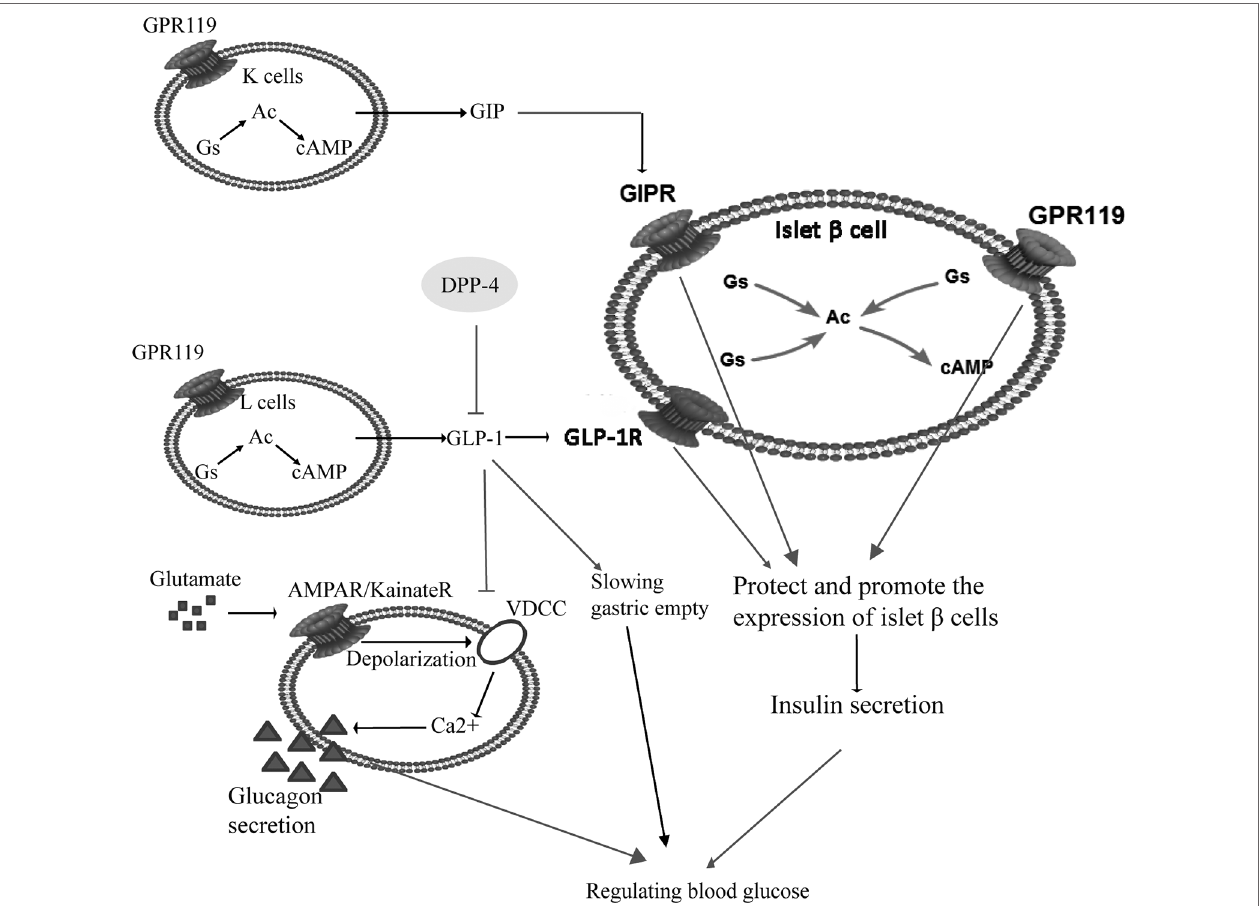
FIGURE 1 | The pathogenesis of type 2 diabetes mellitus (T2DM) and related anti-hyperglycemia targets. Pancreatic β cells secrete insulin, and regulate blood sugar by activation of GLP-1R and GIPR on their surface. In patients with T2DM, after a meal food reaches the gastrointestinal tract and promotes GLP-1 inactivation under the catalysis of DPP-IV. K cells and L cells work together to regulate insulin secretion. GIP and GLP-1 bind with GIPR and GLP-1R respectively, together with GPR119 to protect pancreatic β cells and stimulate the secretion of insulin. Increased GLP-1 inhibit α cells secreting glucagon to lower blood glucose. Meanwhile, GLP-1 reduces brain satiety and slows gastric emptying. Abbreviations: GPR119, G protein-coupling receptor 119; GIP, glucose-dependent insulinotropic polypeptide; GLP-1, glucagon like peptide-1; GIPR, glucose-dependent insulinotropic polypeptide receptor; GLP-1R, glucagon like peptide-1 receptor; Ac, adenylate cyclase; Gs, stimulatory G protein; cAMP, cyclic adenosine